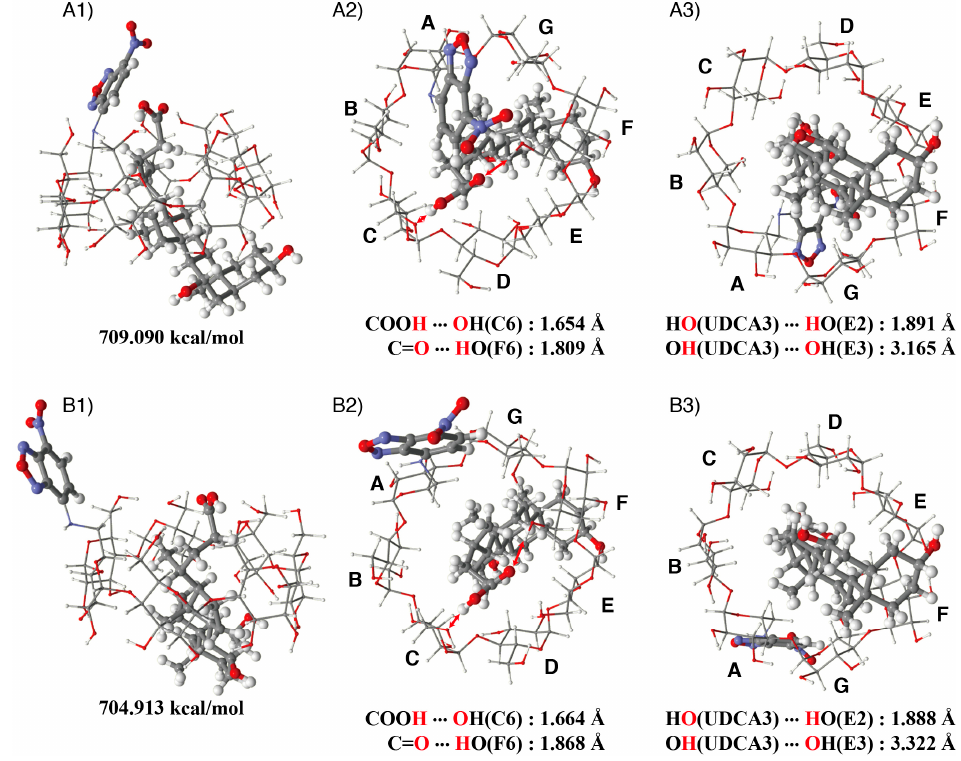
Figure 11. Estimated structure of the NC0 β CD / UDCA complex; ( A ) gt conformer: ( A 1) side view, ( A 2) view from the primary hydroxy side, ( A 3) view from the secondary hydroxy side; ( B ) gg conformer: ( B 1) side view, ( B 2) view from the primary hydroxy side, ( B 3) view from the secondary hydroxy side. The NBDamine units of the NC0 β CD / UDCA complex in both the gt and gg conformers